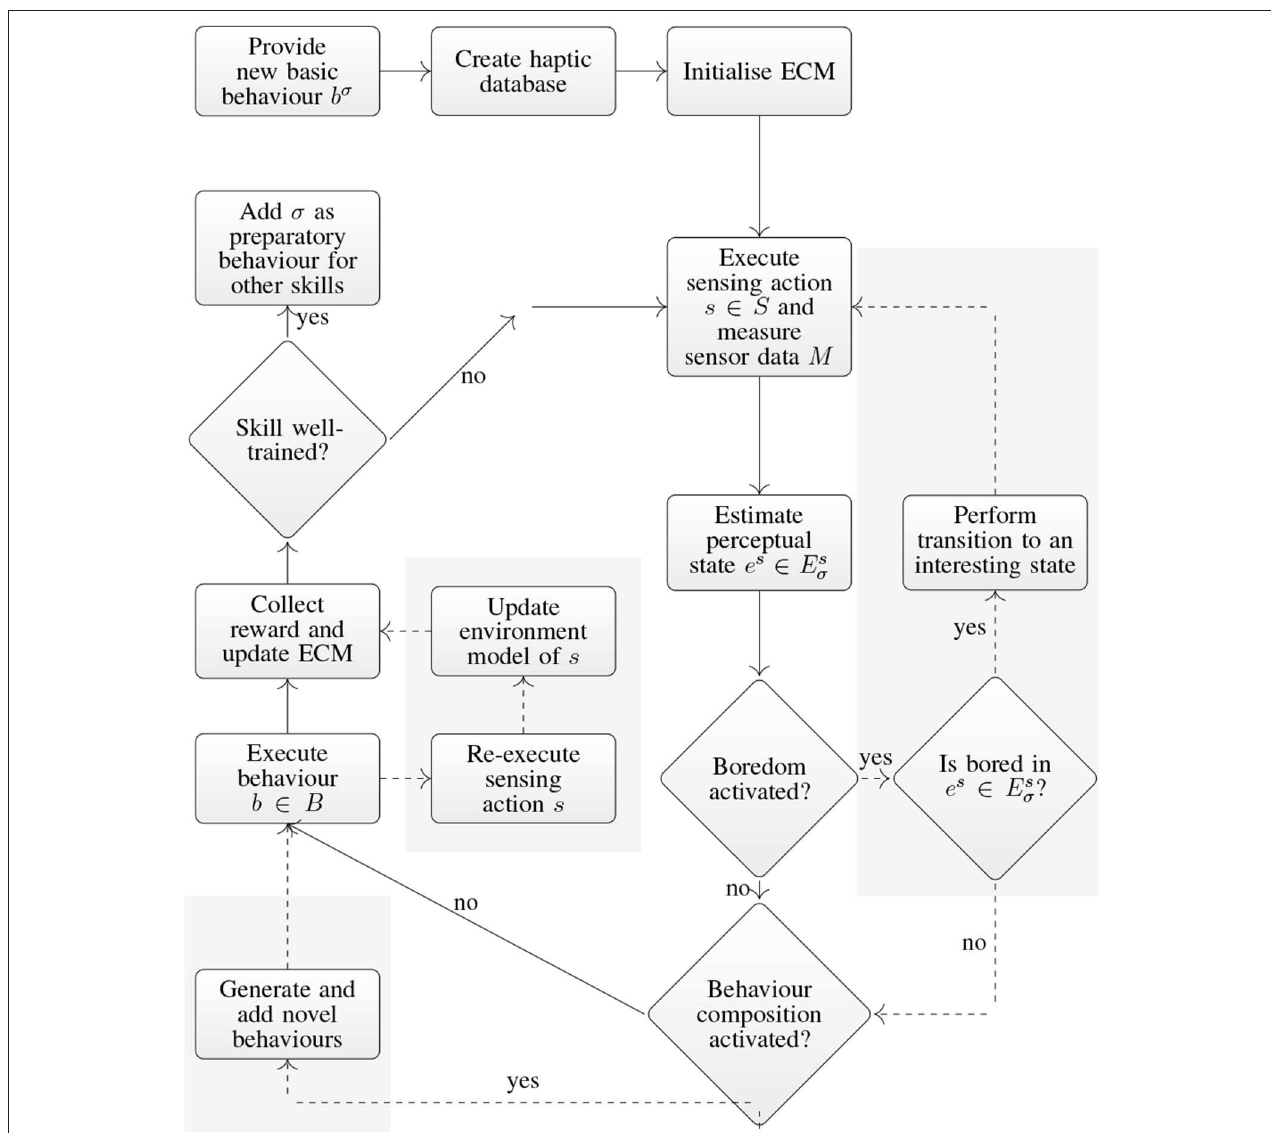
FIGURE 3 | Flow chart of the skill training procedure. A novel skill is trained by showing a new basic behavior. The robot extends the domain of applicability by playing the object, i.e., by performing a random walk through the network shown in Figure 2 . The solid lines indicate the behavior of the basic approach (Hangl et al., 2016). The shaded areas and dashed lines show the proposed extensions, i.e., training of an environment model , boredom , and composite behavior generation